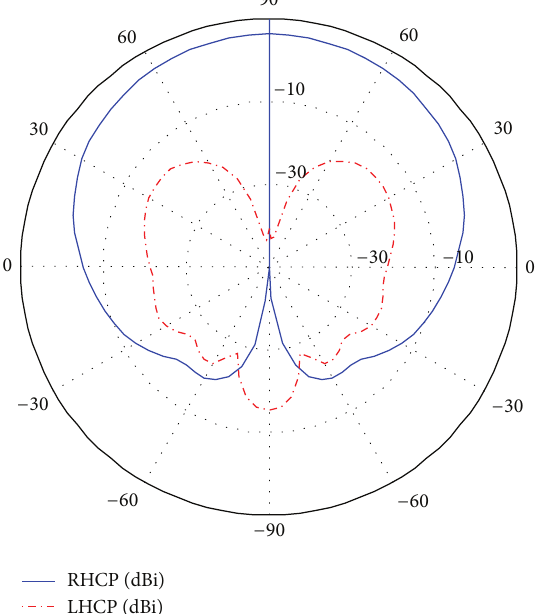
Figure 3: The RH and LHCP amplitude patterns for the choke antenna at L1 (phi = 0).